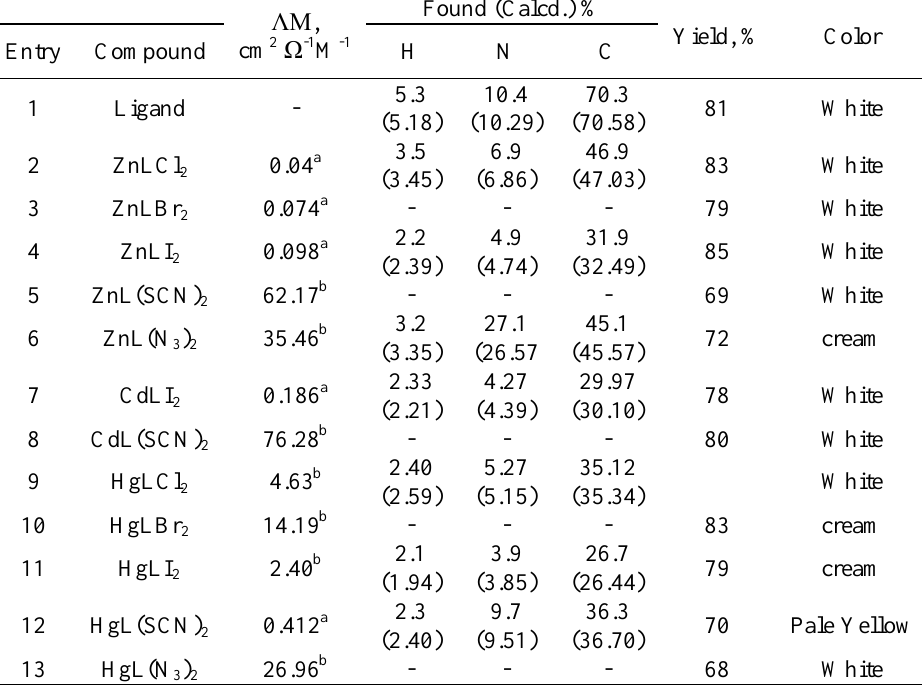
Table 1. Elemental analysis, color, %yield and molar conductivity of the ligand and its